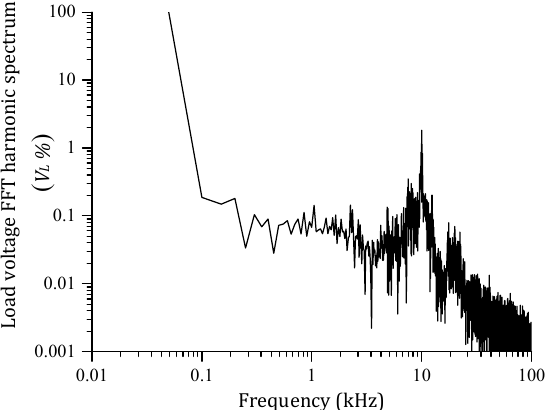
Figure 14. House load current FFT harmonic spectrum at 2 kW.